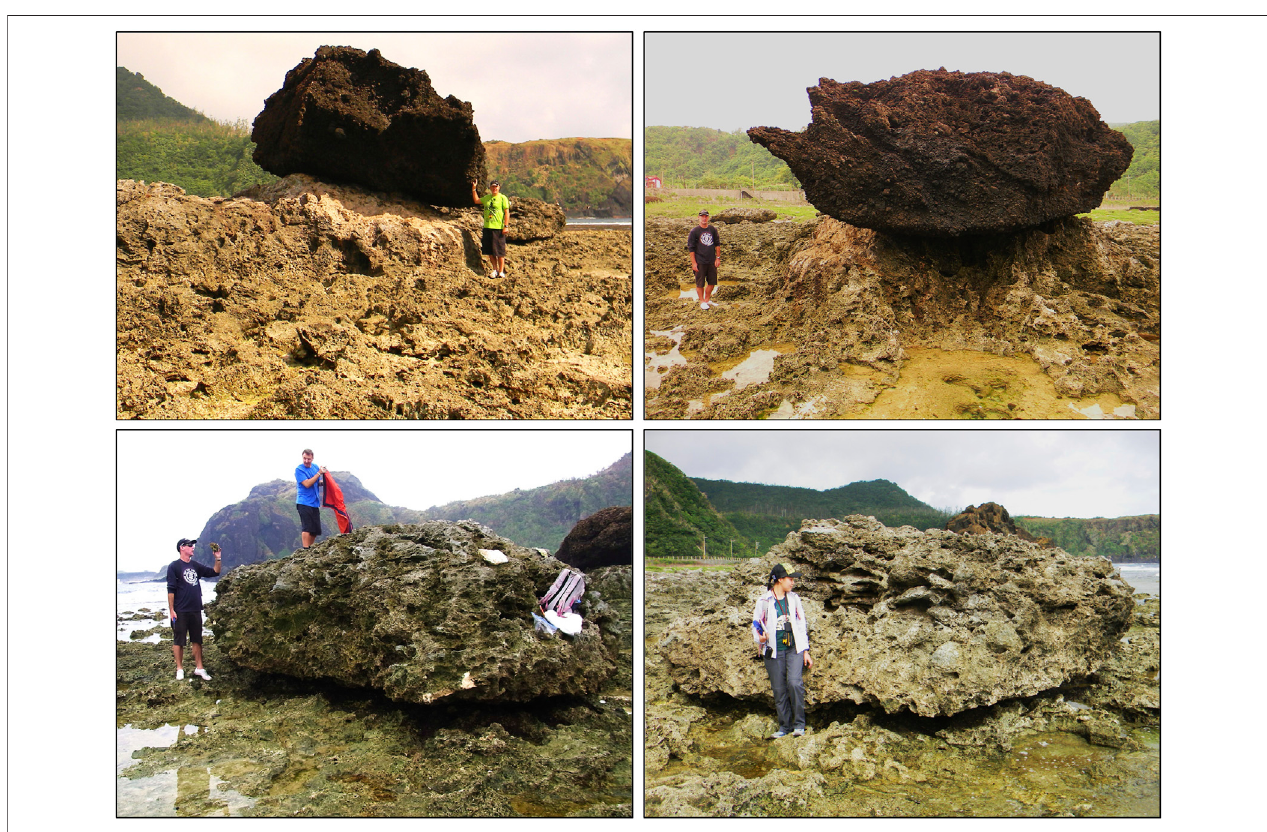
FIGURE 5 | The largest coastal boulders observed on Dahu Reef. Above: Two views of a volcanic agglomerate megaclast (6.6 × 4.6 × 3.3 m) weighing approximately 150 t, perched on a pedestal of Holocene reef above the surrounding platform (22 ° 38.89 ′ N 121 ° 30.02 ′ E). This individual is not believed to be a wave- transported clast. Because the pedestal of limestone is protected from rainwater solution by the volcanic boulder resting on top, the highest point of the pedestal now stands2.5 mhigherthanthesurroundingreeflevel.Below:Thelargestlimestoneclastobservedatthestudysite(22 ° 38.89 ′ N121 ° 30.03 ′ E)issimilarlyofmegaclast proportions, measuring 5.9 × 4.4 × 2.6 m and weighing approximately 73 t. Limestone clasts have been quarried from the reef by wave action and subsequently wave- transported to their current locations, by one or more past HEW events.